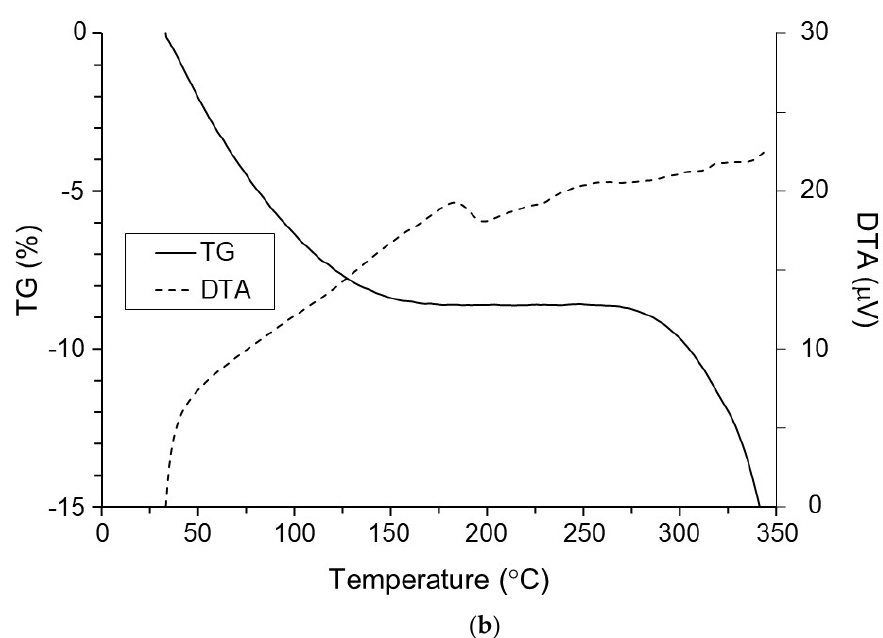
Figure 2. Typical TG/DTA profiles for ( a ) AntiY 5 R and ( b ) NaTC.